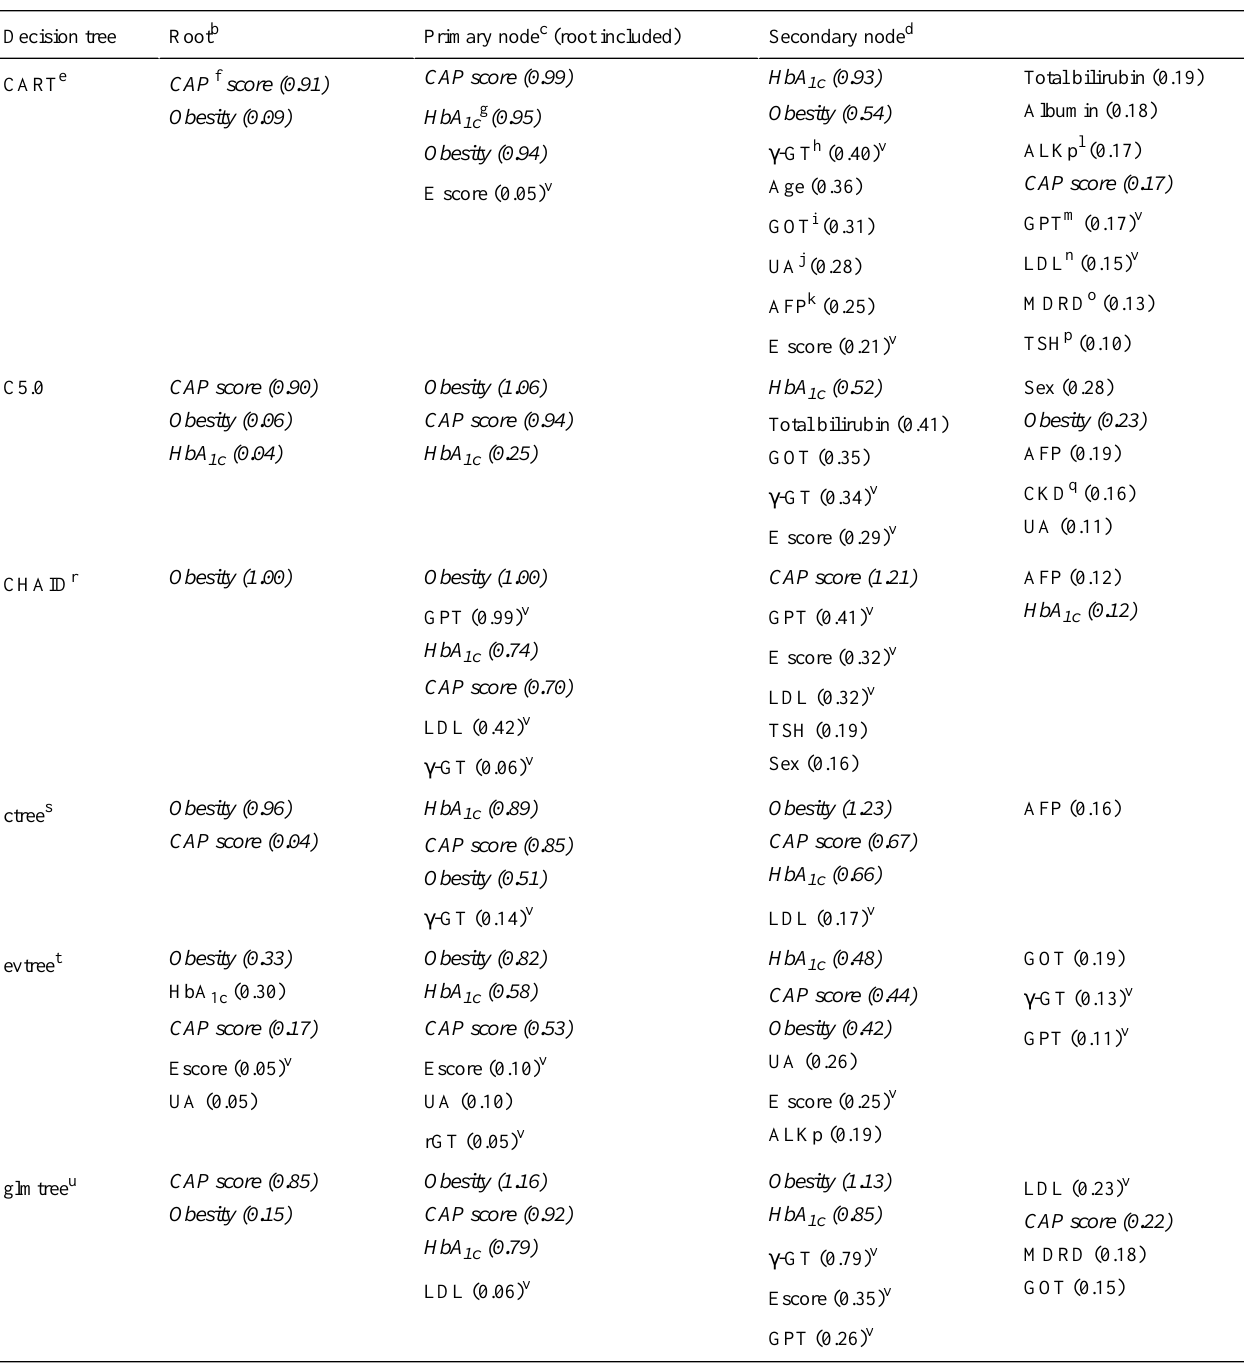
Table 3. Major factors as classified nodes in decision trees a